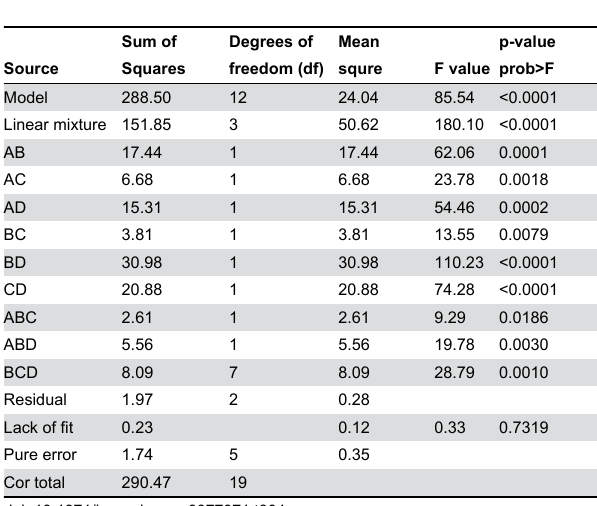
Table 4. Analysis of variance (ANOVA) for all the terms of